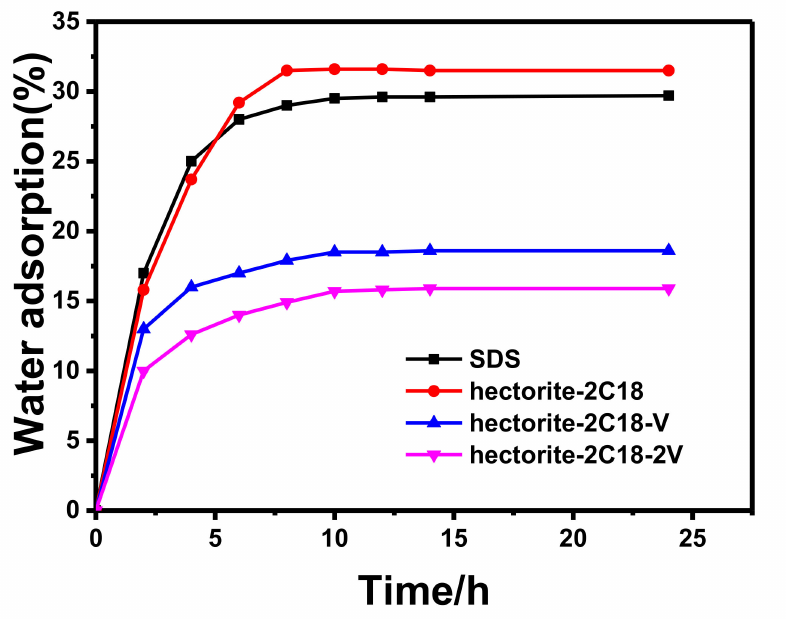
Figure 9. Water adsorption of polyacrylate latex films prepared with SDS (1 wt%), Laponte-2C18